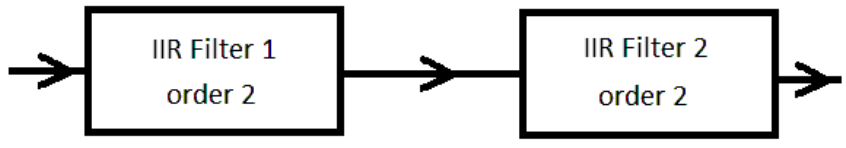
Figure 5. Run parameter estimation